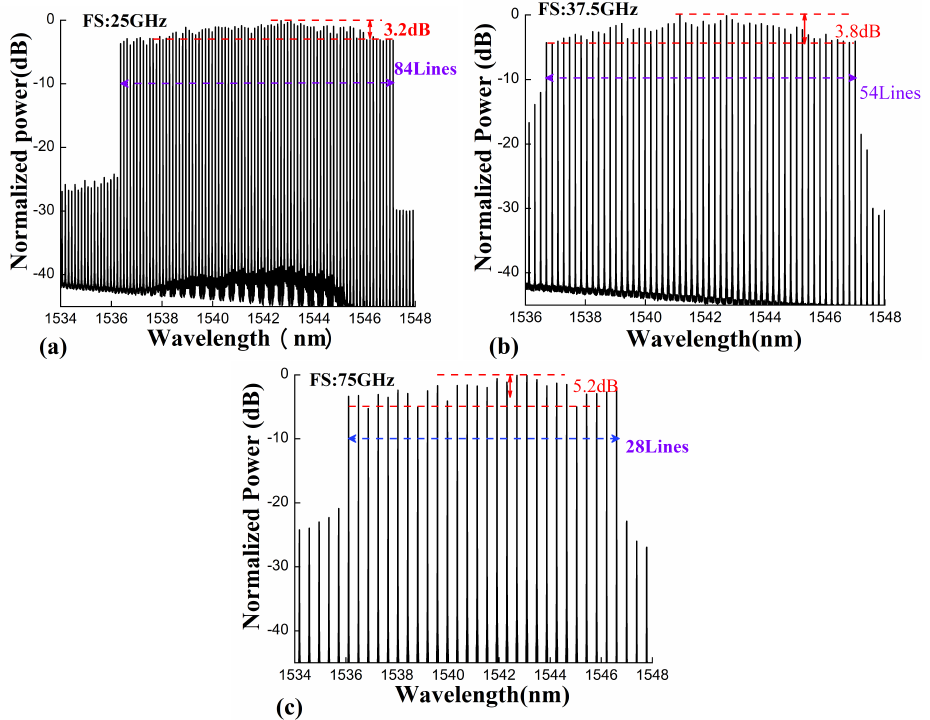
Figure 2. The measured maximum power deviation within the 10 dB spectrum of OFC with frequency spacing of ( a ) 25, ( b ) 37.5 and ( c ) 75 GHz. FS: Frequency